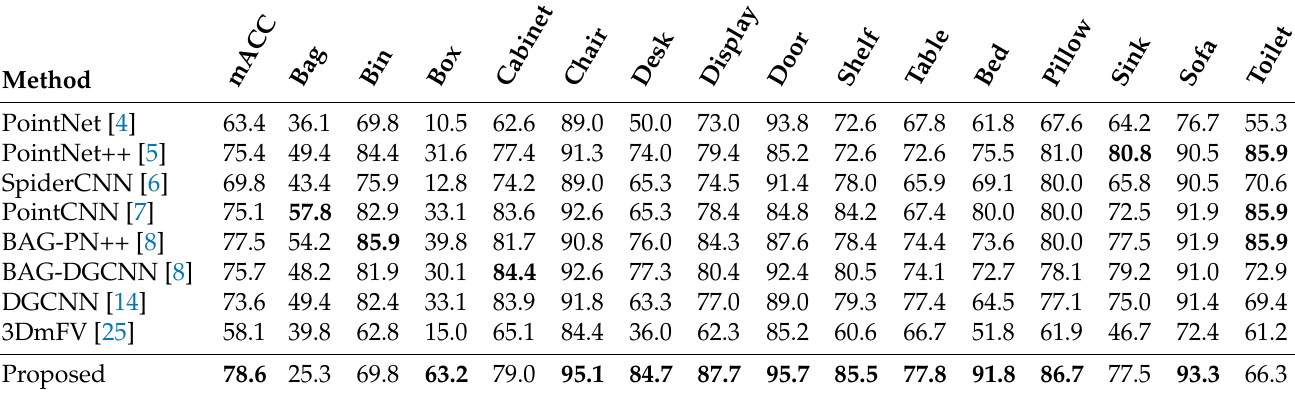
Table A4. Per-class accuracies (in %) for ScanobjectNN-PB_T50_RS. PSNet achieves the best mACC accuracy. It also performs better than all of the compared methods for the categories of box, desk, display, door, shelf, table, bed, pillow, and sofa,